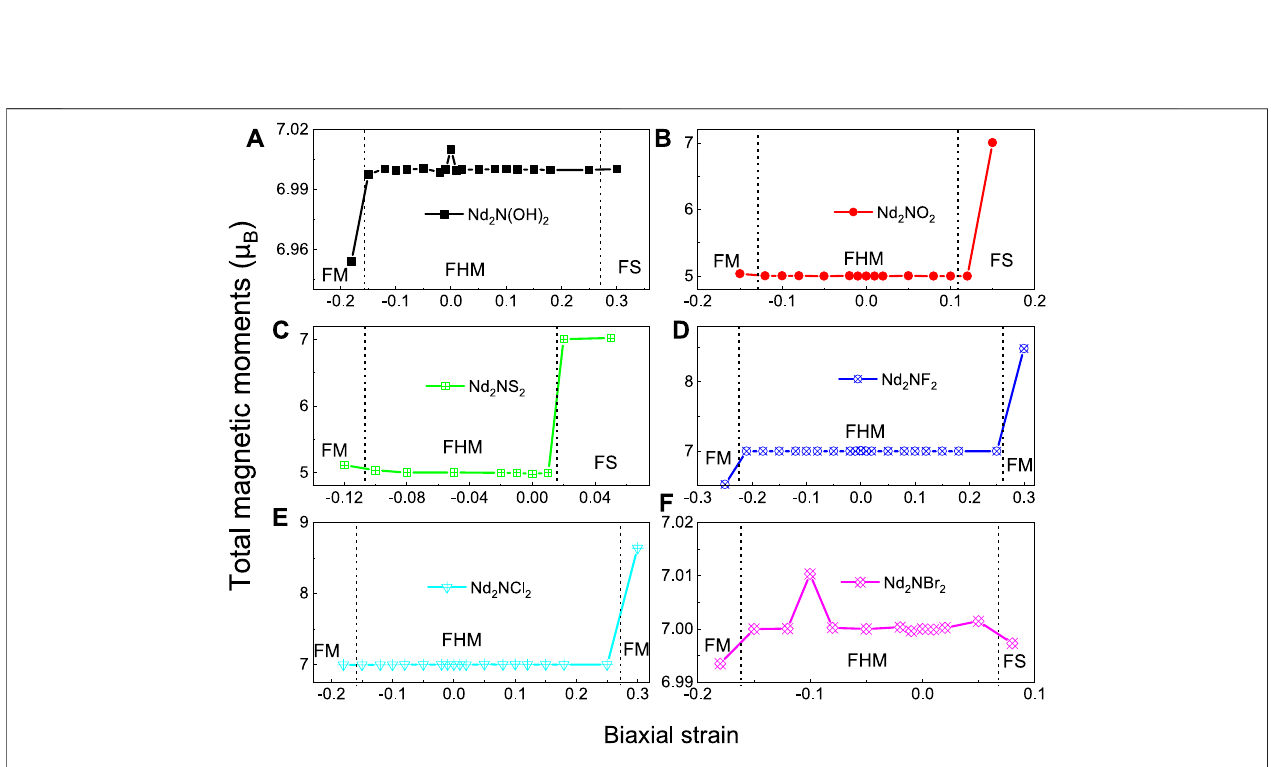
FIGURE6| TotalmagneticmomentsofmonolayerNd 2 NT 2 (T=OH,O,S,F,Cl,andBr)underbiaxialstrain. (A) Nd 2 N(OH) 2 , (B) Nd 2 NO 2 , (C) Nd 2 NS 2 , (D) Nd 2 NF 2 , (E) Nd 2 NCl 2 , (F) Nd 2 NBr 2 . FM, FHM, and FS denote ferromagnetic metallic, ferromagnetic half-metallic, and ferromagnetic semiconductor, respectively.